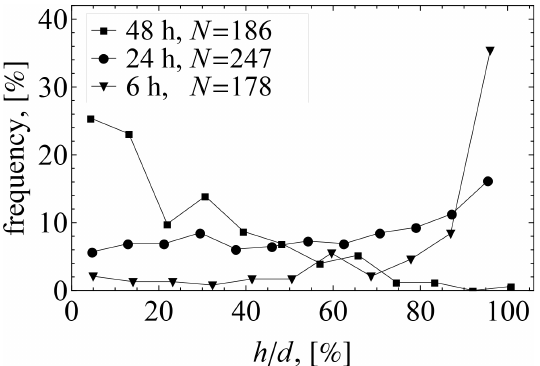
Figure 7. Evolution of the fraction of grooves identified to be due to dissolution. The images show schematic differences in surface ge- ometry for long and short experiments (see also Fig. 4) for which a switch from preferential dissolution of c = ( 0001 ) surfaces to pref- erential growth on these relative to prismatic surfaces b = ( 1010 ) is observed.